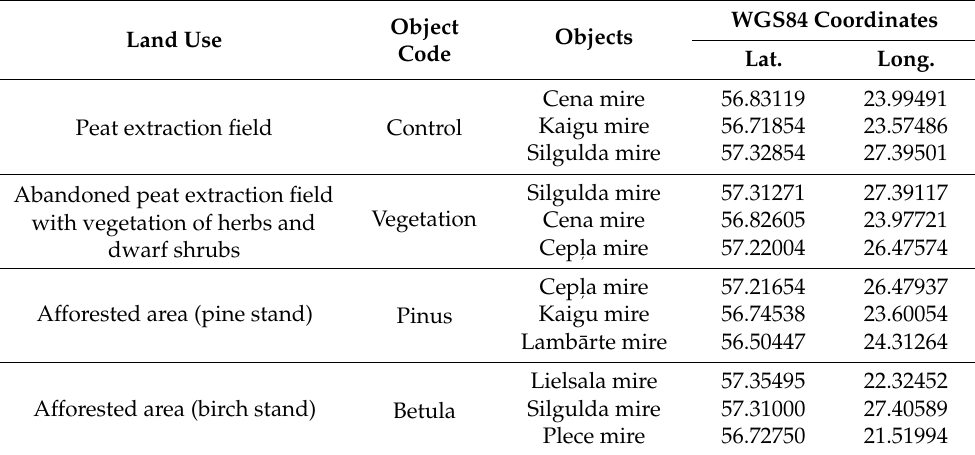
Table 1. Study objects by land use type and management